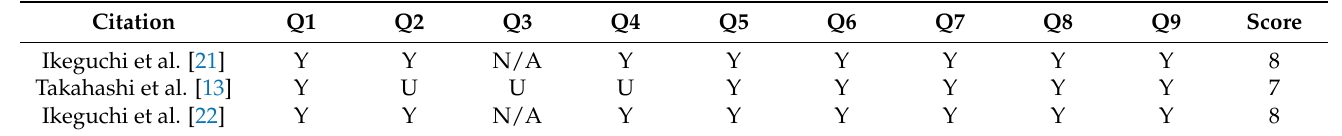
Table A1. Appraisal result of study quality for quasi-experimental studies using the JBI-MAStARI (see Method Section 2.4 for questions 1–9).